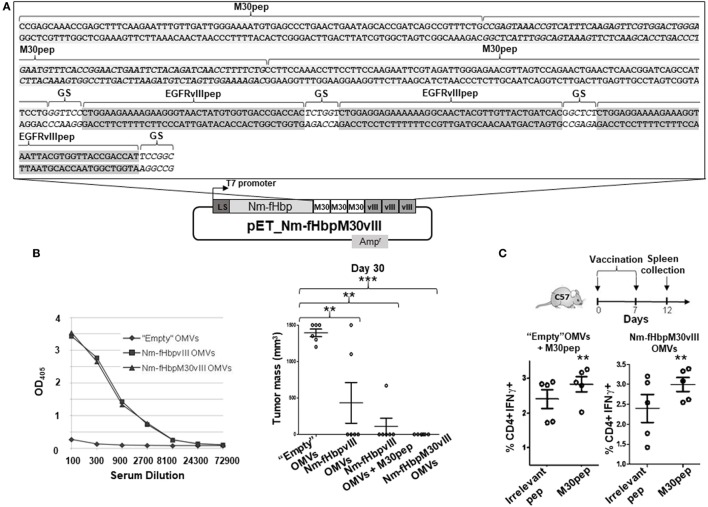
Immunogenicity and protective activity of outer membrane vesicles (OMVs) decorated with Nm-fHbp-M30-vIII fusion. (A) Schematic representation of pET-Nm-fHbp-M30-vIII plasmid. The DNA sequence refers to the 3′ end of the gene fusion encoding three copies of both M30 and EGFRvIII epitopes. (B) Mice were immunized with (i) “Empty” OMVs, (ii) Nm-fHbpvIII OMVs, and (iii) Nm-fHbpvIII OMVs + M30pep, and (iv) Nm-fHbp-M30-vIII-OMVs and subsequently challenged with 0.5 × 105 B16F10EGFRvIII cells following the schedule indicated in Figure 2A. Tumor size in each mouse was measured at day 30 post challenge. Seven days after the last immunization, serum samples were also collected from mice immunized with (i) “Empty” OMVs, (ii) Nm-fHbpvIII OMVs, and (iii) Nm-fHbp-M30-vIII-OMVs, and total anti-EGFRvIII IgGs were measured by ELISA (**P < 0.01; ***P < 0.001). (C) M30-specific CD4+ T cells induced in mice immunized with OMVs decorated with M30 peptide. Mice were immunized twice i.p. at days 0 and 7 with either 20 µg “Empty” OMVs + 100 mg M30pep or 20 µg Nm-fHbp-M30-vIII-OMVs. Five days after the second immunization, splenocytes were stimulated with either an irrelevant peptide or with M30 peptide and IFNγ-positive CD4+ T cells were counted by FACS (**P < 0.01).